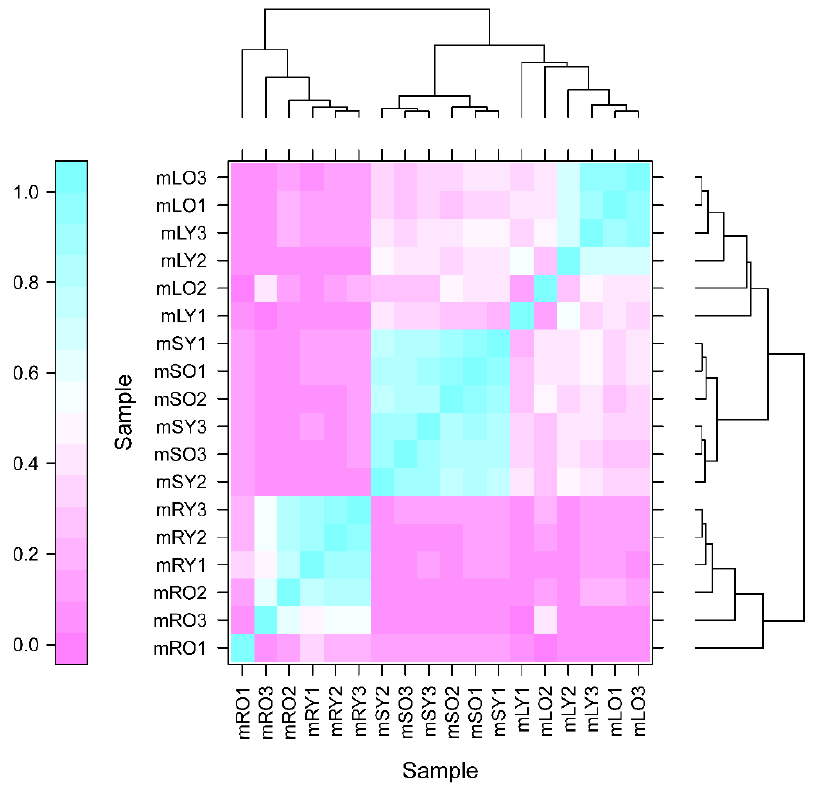
Figure 1. Heatmap of the expression correlation between two samples. Young roots, young stems, and young leaves are represented by mRY, mSY, and mLY, respectively, and mature roots, mature stems, and mature leaves are represented by mOR, mOS, and mOL, respectively. The numbers after the sample names indicate the plant numbers from different biological